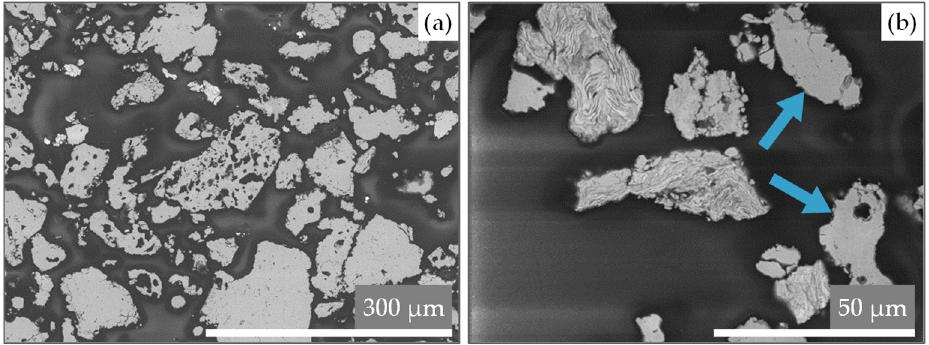
Figure 6. SEM images of reacted particles in exemplary areas of the sample (experiment no. 17). ( a ) 300-fold magnification ; ( b ) 1500-fold